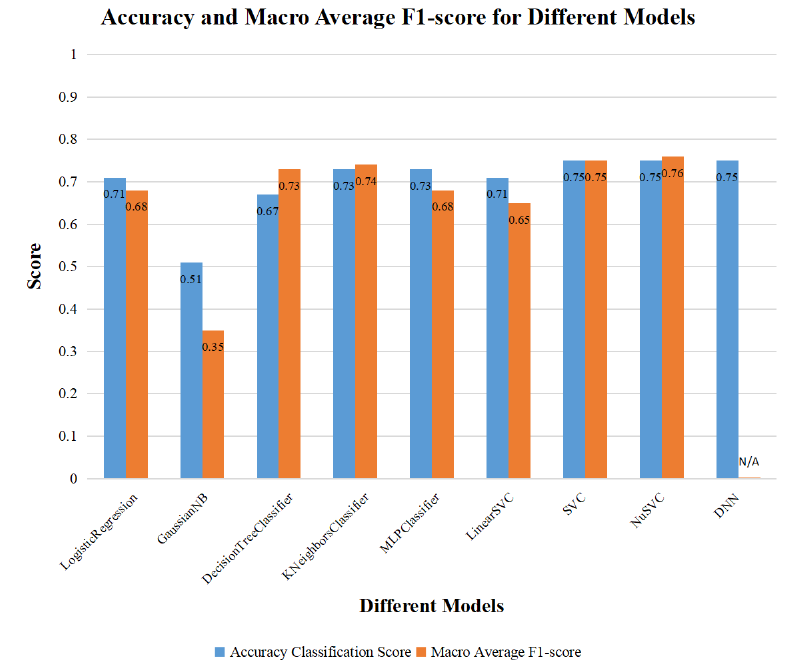
Figure 7. Accuracy and macro average F1-score for different models.